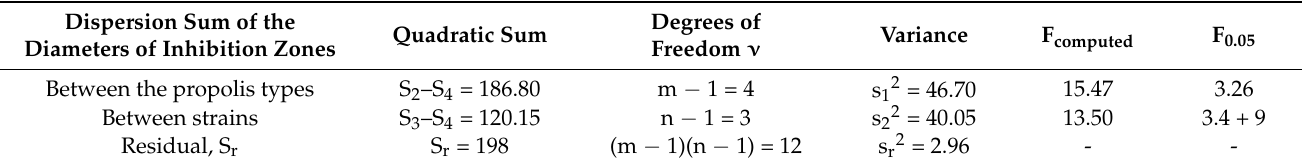
Table 4. Statistical bifactorial variance analysis for propolis